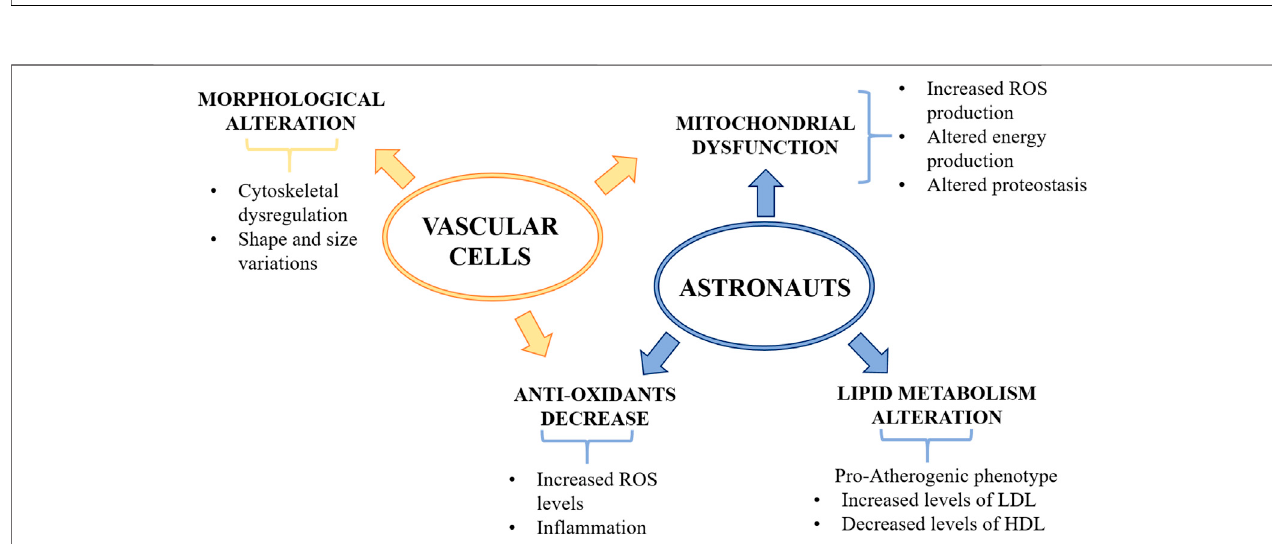
FIGURE 2 | The effects of microgravity on the vascular system. Microgravity decreases anti-oxidant defenses and induces mitochondrial dysfunction, thus increasingoxidativestressandimpairingenergyproductionandproteostasis.Dysregulationoflipidmetabolismwasfoundinastronautswhichshowedincreasedlevelof LDL and decreased level of HDL. Vascular cells exposed to microgravity showed morphological alterations, such as cytoskeletal dysregulation and shape and size variations. ROS, reactive oxygen species; LDL, low density lipoprotein; HDL, high density lipoprotein.